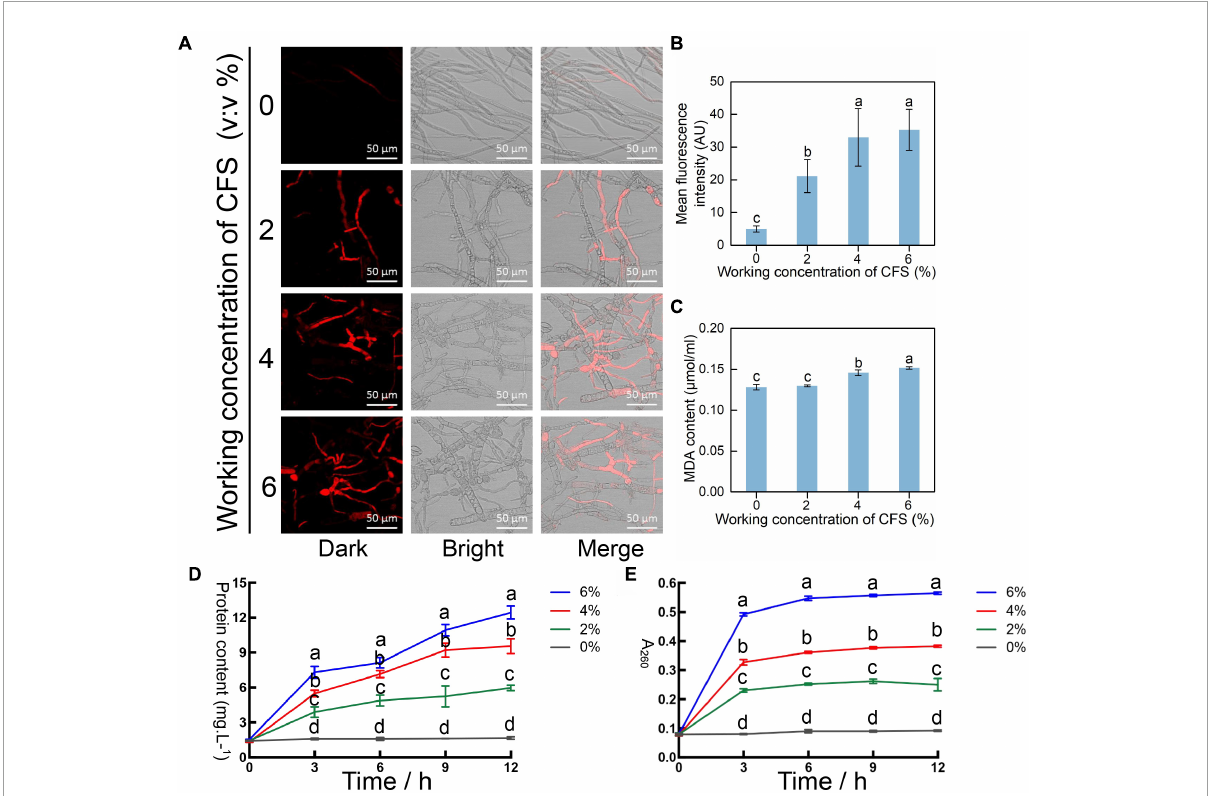
FIGURE6 Injury efficacy of cell-free supernatant (CFS) on the hyphal cytomembrane of Botrytis cinerea in vitro . (A) Detecting the integrity of membrane of hyphal cells at 24 h after the application of CFS was stained by propidium iodide (PI). The fluorescence signal was detected using a laser scanning confocal microscope at 405 nm excitation and 633 nm emission. (B) The relative intensity of fluorescence of each treatment was measured by ImageJ. (C) Malondialdehyde (MDA) content which refers to the degree of membrane lipid peroxidation of hyphal cells, was recorded after treatment with CFS for 24 h. (D) Total protein content in hyphae culture medium after a different amount of CFS treatment. (E) Nucleic acid content as measured by A 260 in hyphae culture medium after different amounts of CFS treatment. Vertical bars represent standard deviations of the means. Treatments followed by different letters are statistically different by the Duncan’s multiple range ( p <